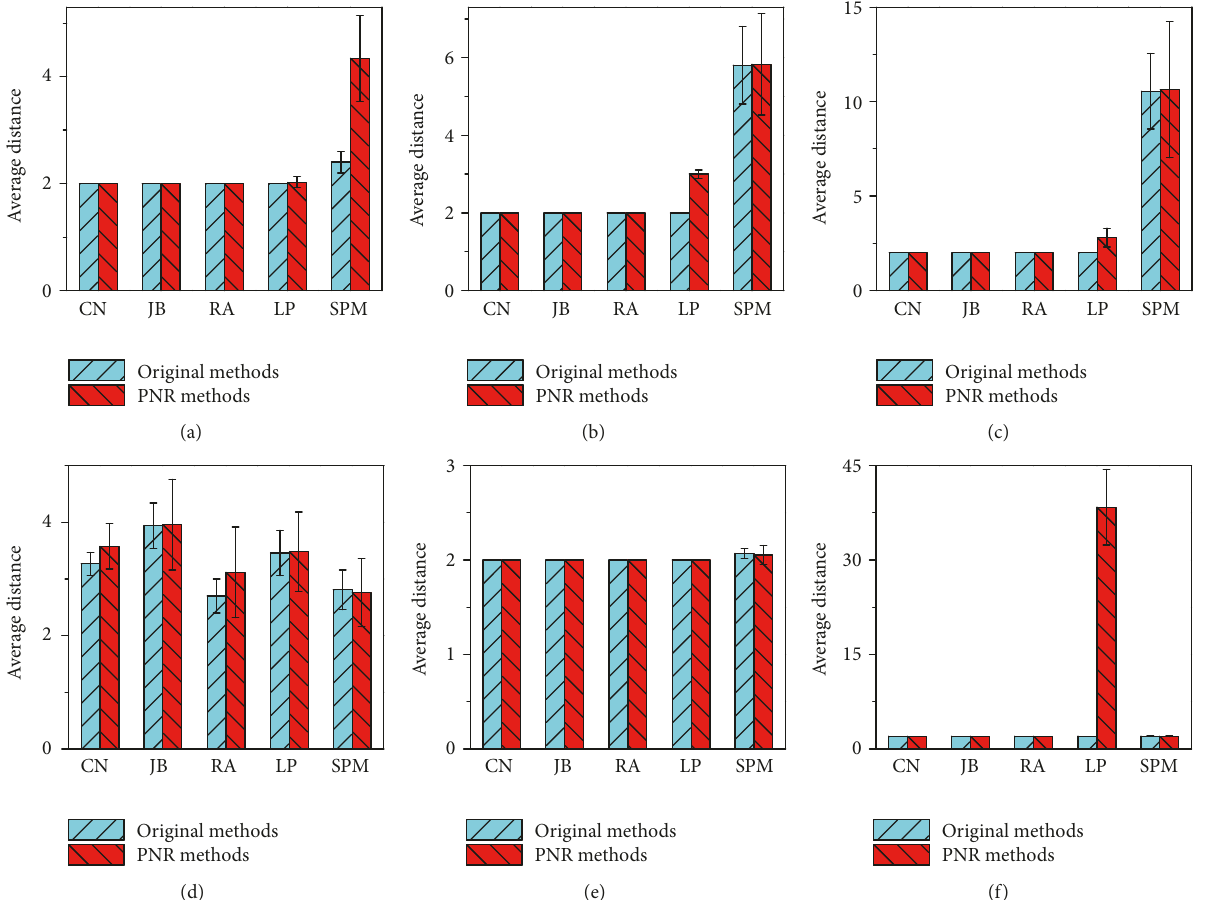
Figure 7: Comparison of average distance of the PNR predicted links with that of the corresponding original methods for different networks. (a) Email network. (b) PDZBase network. (c) Euroad network. (d) Neural network. (e) Roundworm network. (f) USair network. Results are the average of 50 independent simulations. Our proposed framework increases the average distance on the whole, which indicates that more long-range links are predicted